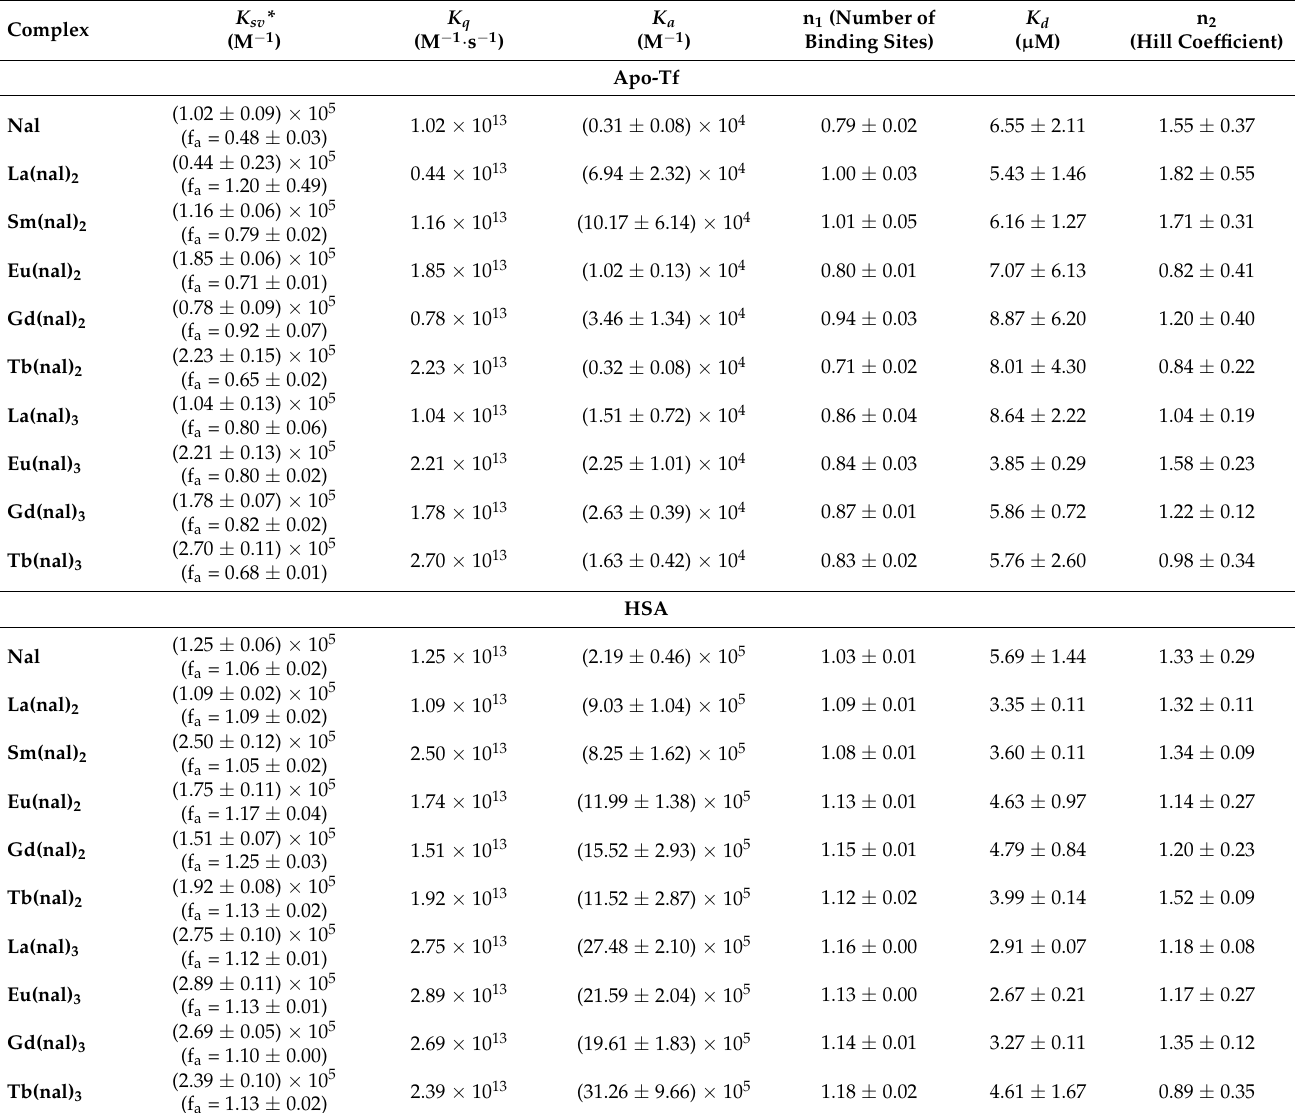
Table 3. Binding constants and thermodynamic parameters calculated for the interaction of the complexes with HSA and apo-Tf at 298